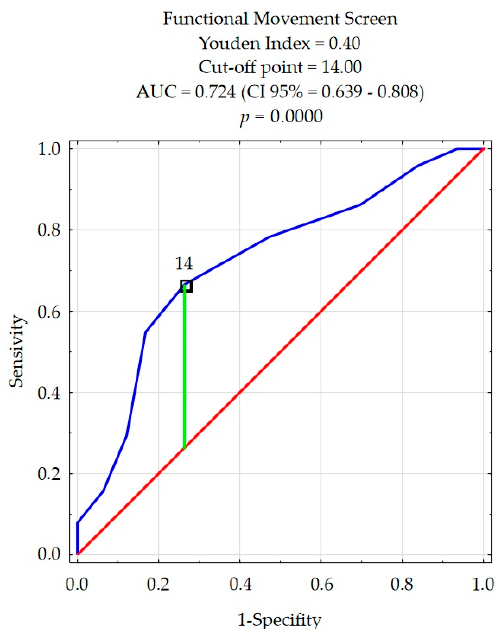
Figure 1. The cut-off point for quality movement patterns by frequency of injuries.